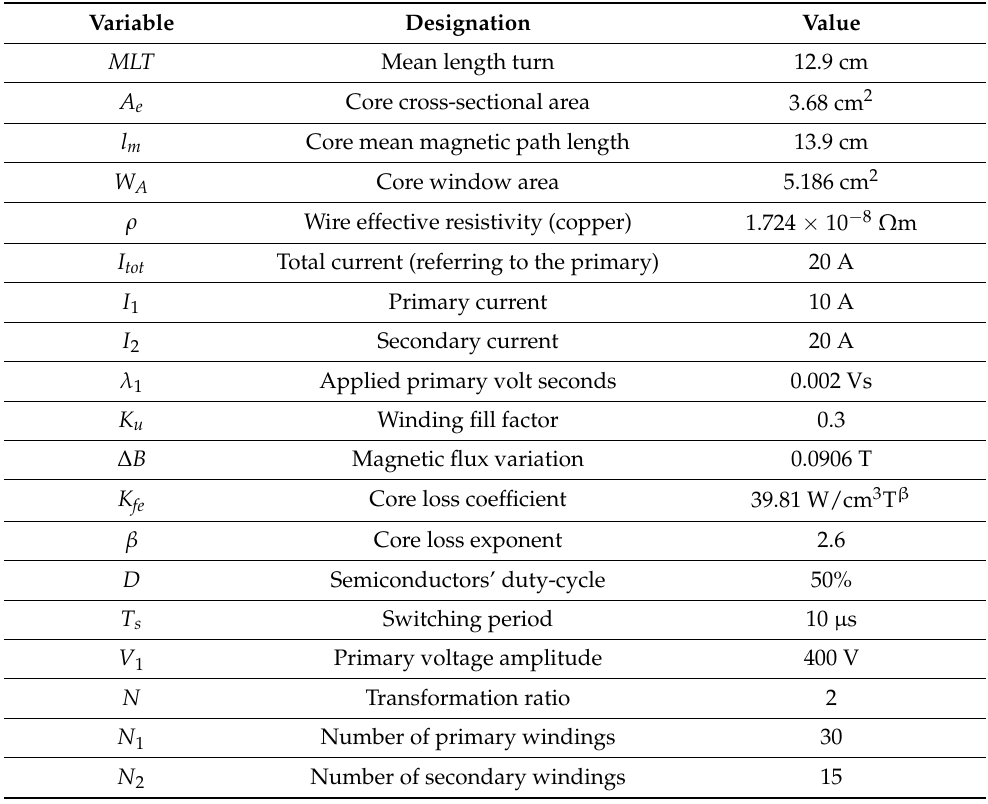
Table 2. Variables and parameters considered in the design of the high-frequency